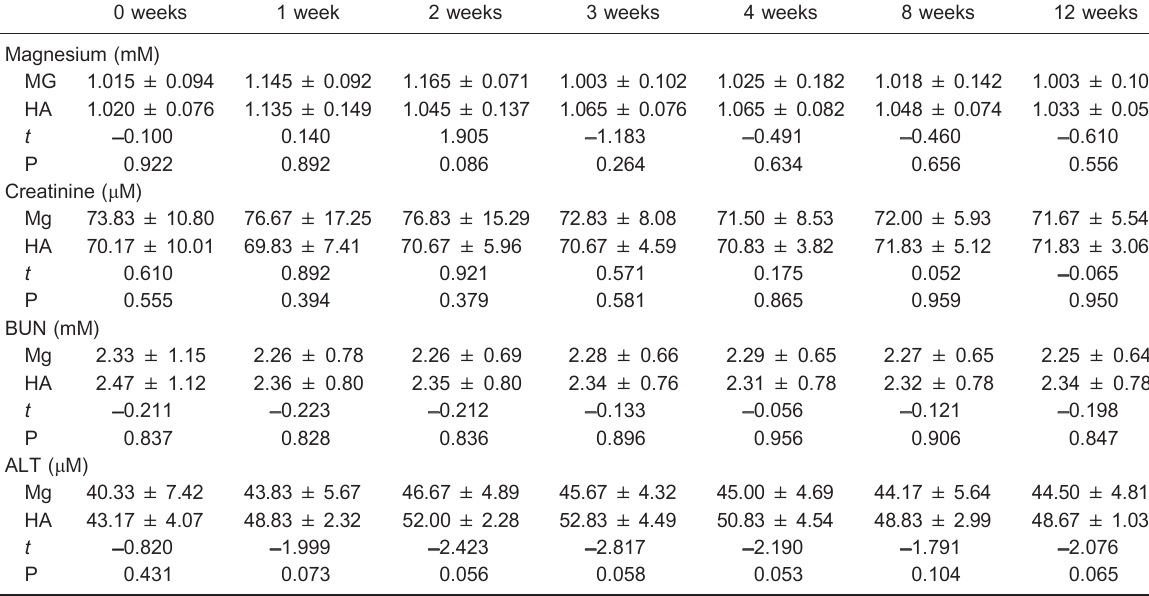
Table 2. Concentrations of serum magnesium, creatinine, ALT, and BUN of the magnesium scaffold group and the hydroxyapatite scaffold control group (mM) at baseline to 12 weeks.